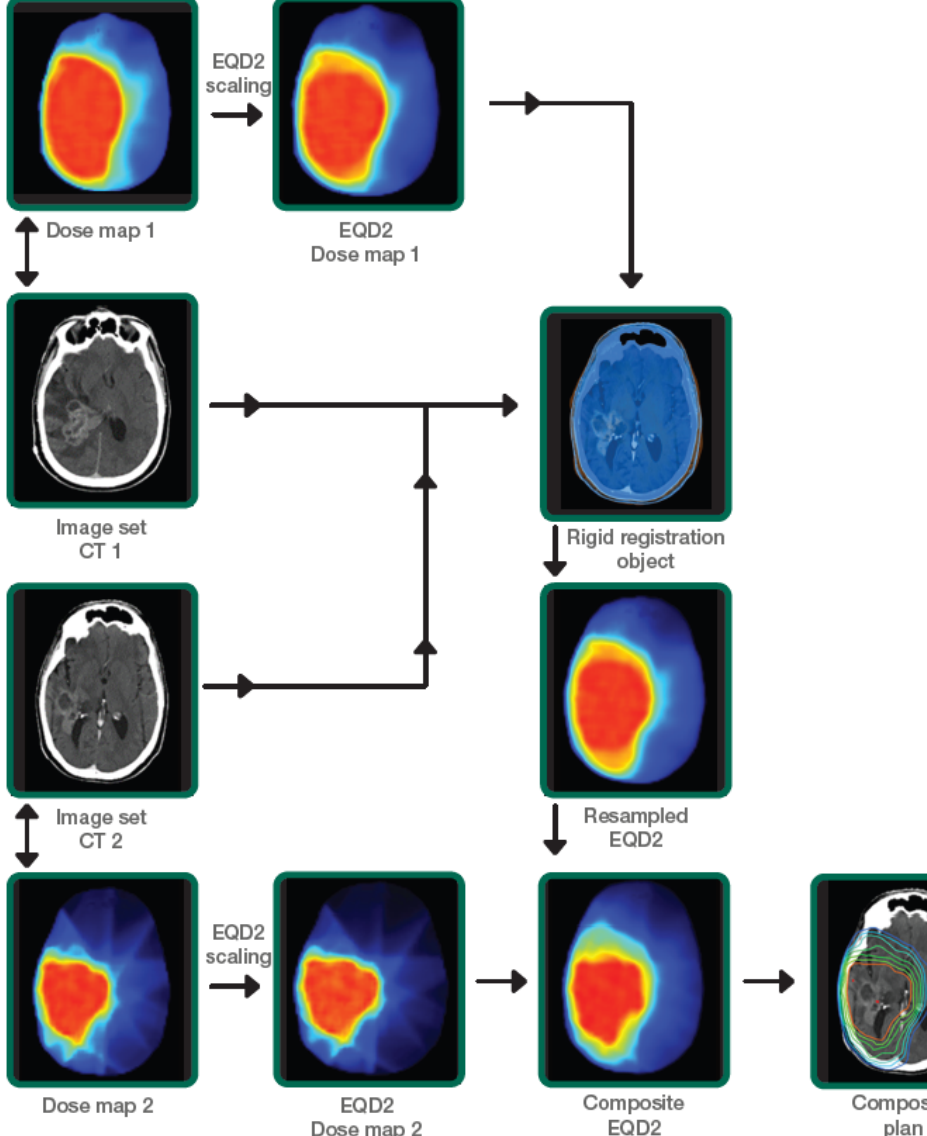
Figure 1. Institutional workflow demonstrating the calculation of EQD2 dose summation using prior dose and PRDR dose distributions.